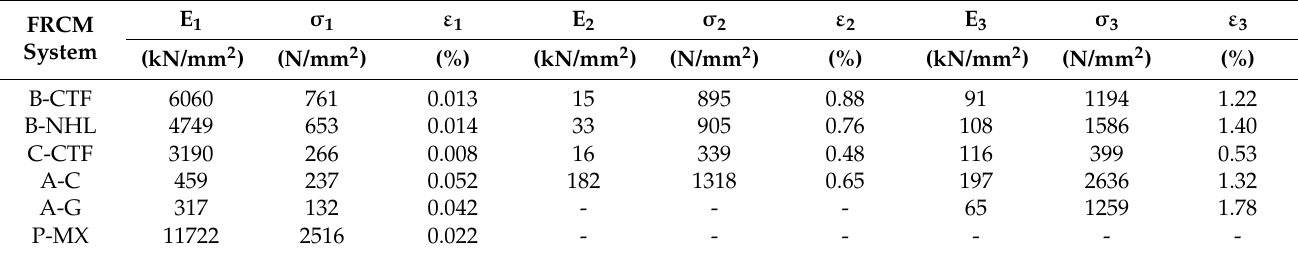
Table 13. ACI and RILEM idealised curves